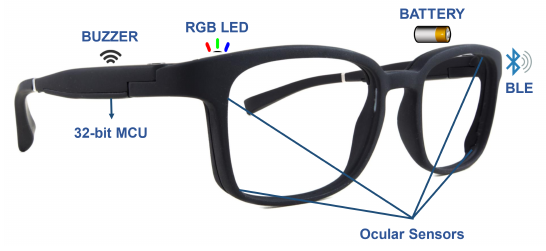
Figure 1. Ellcie Healthy Smart Glasses.